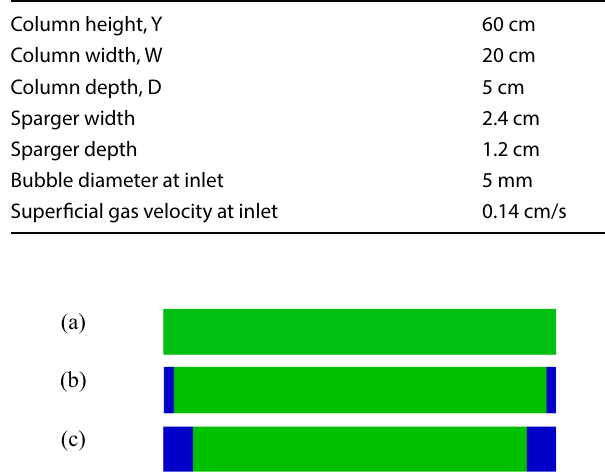
Table 1 Dimensions and other conditions of the bubble column used for the validation study Parameters